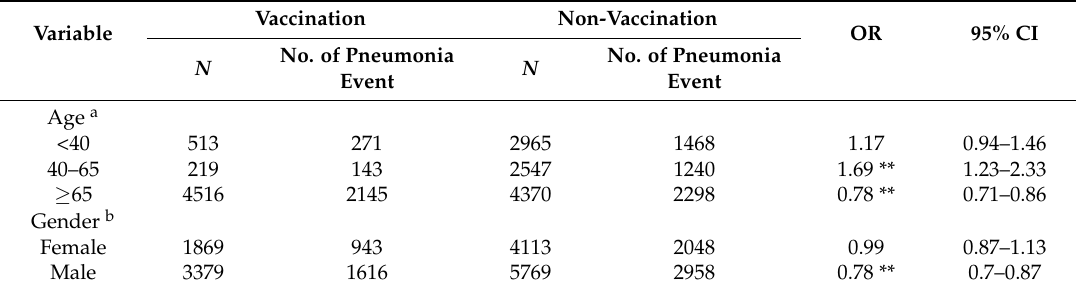
Table 4. Subgroup analysis of the conditional logistic regression between vaccination and non- vaccination